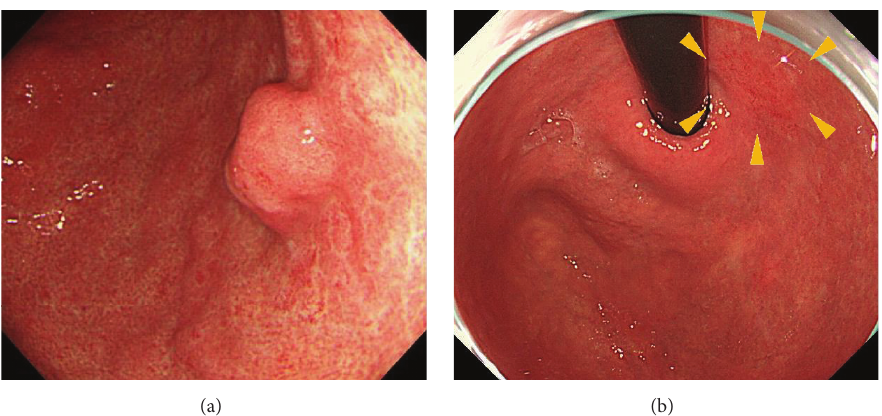
Figure 3: A metachronous lesion. A reddish depressed (type 0-IIc) lesion (b: yellow arrowhead) was detected after 60 months of initial ESD and subsequent H. pylori eradication for the initial lesion